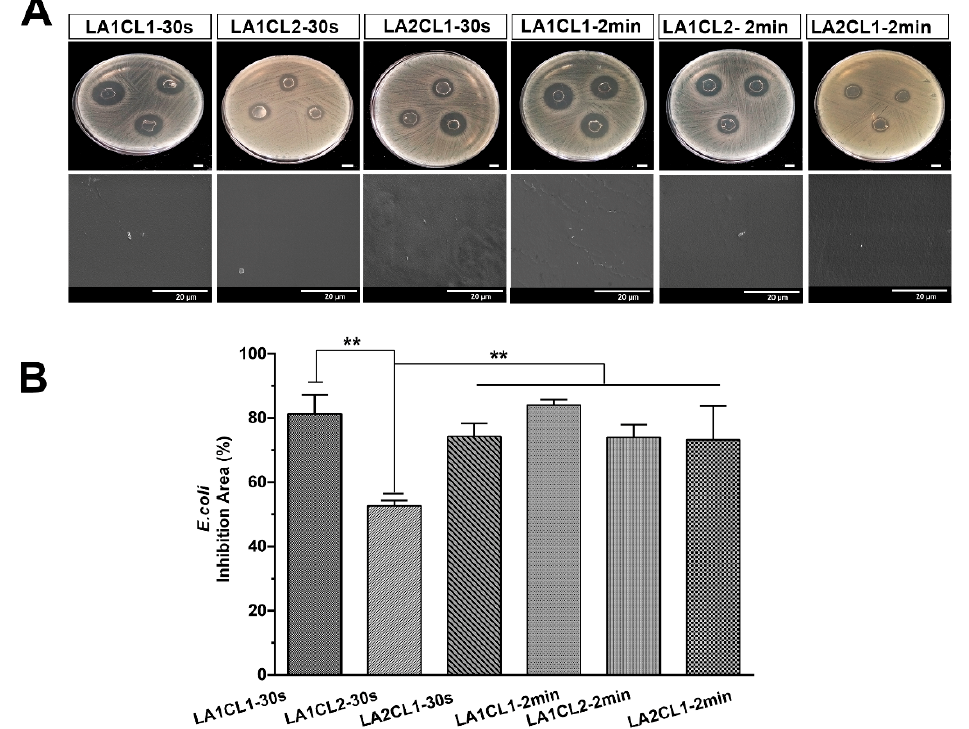
Figure 9. Assessment of antimicrobial profile of the photocrosslinked films against E. coli . ( A ) Macroscopic images of the inhibitory halos. ( B ) Relative value of the inhibition area presented by the films. Data are presented as the mean ± standard deviation, n = 3.